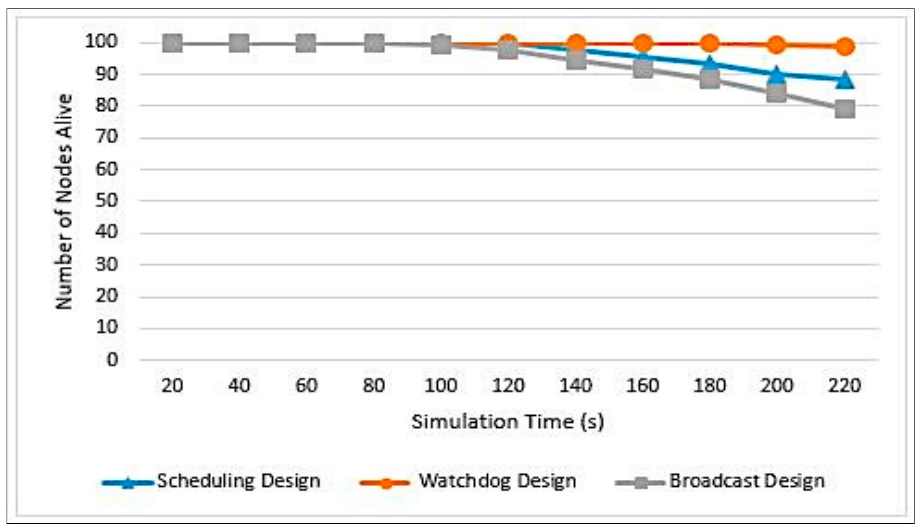
Figure 13. Number of nodes alive measurements.